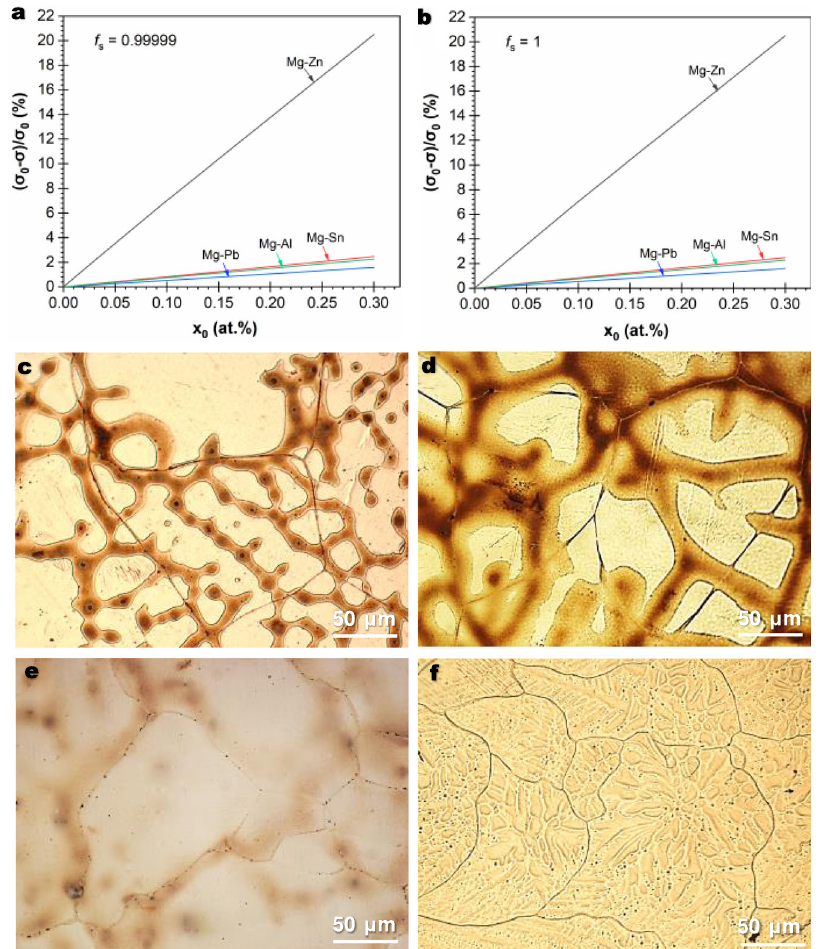
(cid:3) (cid:4) = σ solute type on σ 0 (cid:2) σ I 0 . c Mg-0.3 at.%Sn, profound SGBM. d